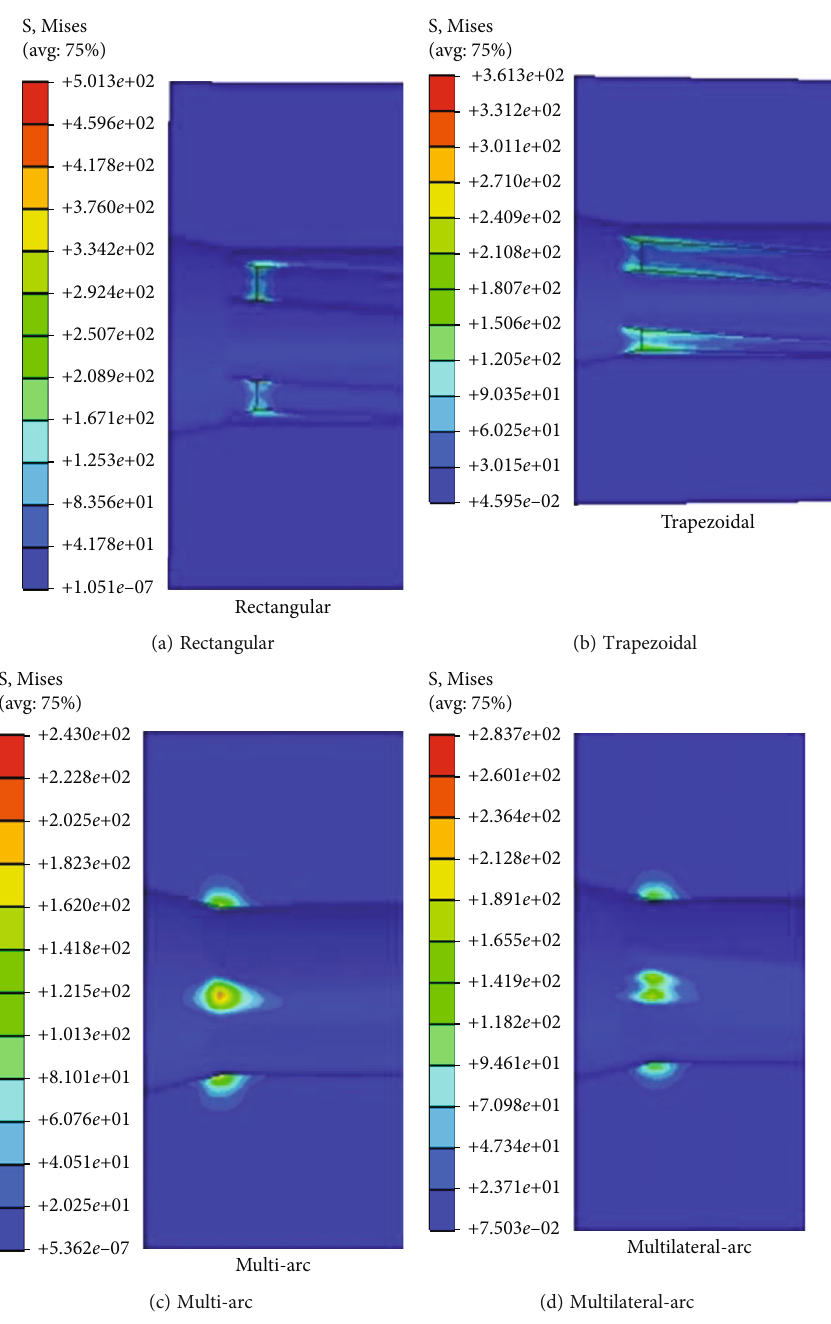
Figure 14: Nephograms of the barrel stress at the early stage of bullet engraving into the forcing